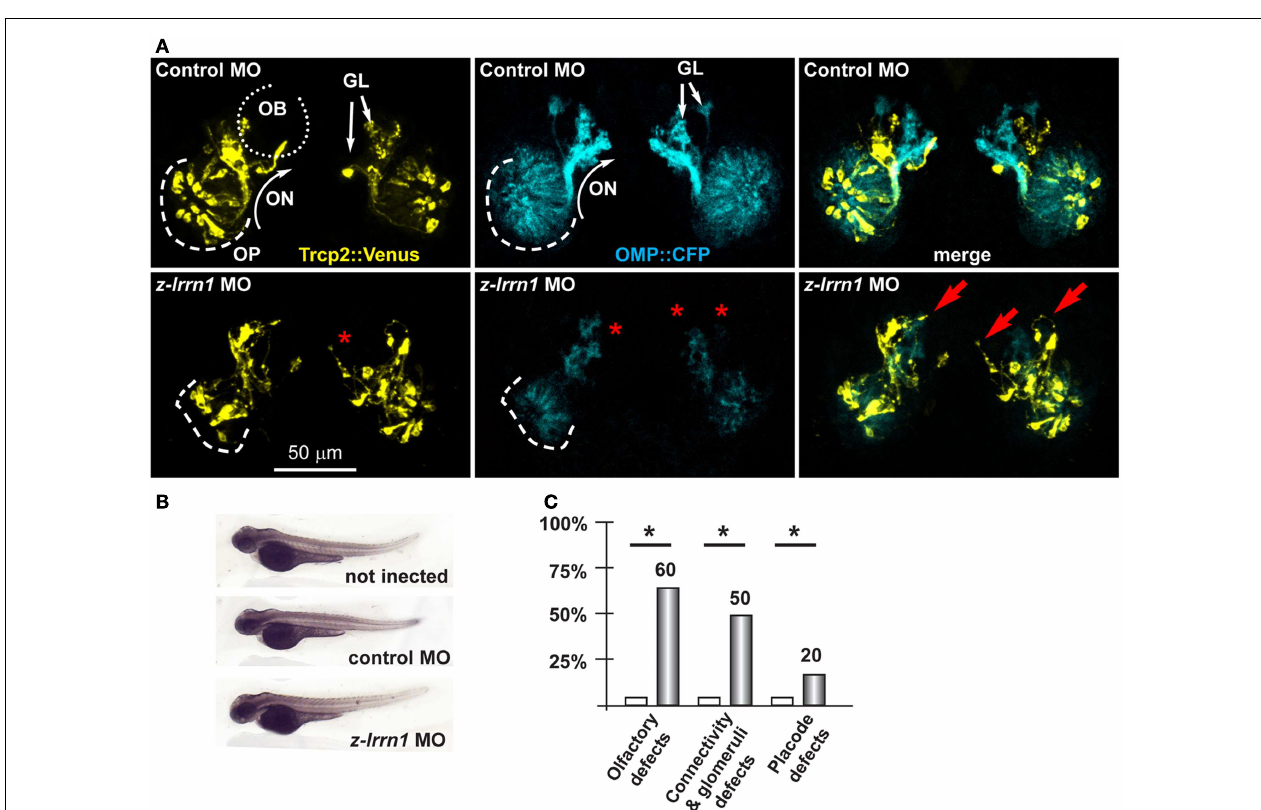
Red asterisks indicate absence of glomeruli. Red arrows indicate altered axonal trajectories. (B) Whole-mount bright field micrographs of injected embryo, showing normal embryonic morphology and growth rate. (C) Proportions of embryos showing either OPL disorganization, or olfactory axon mistargeting, or both (last bars) upon injection of control (open bars) or anti- z-lrrn1 (gray bars)